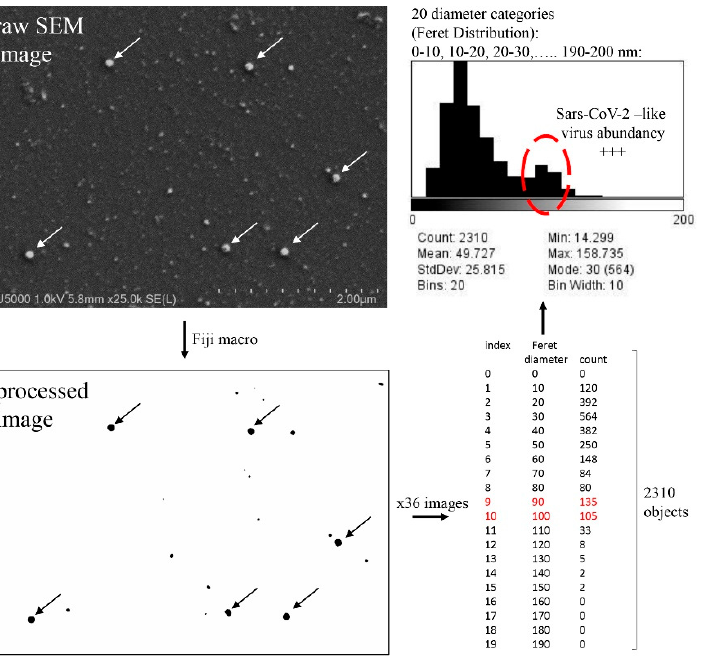
Figure 6. Example of Fiji macro for depicting 5 nm to 200 nm diameter particles in SEM images of SARS-CoV-2-infected cell culture supernatants. In this example SARS-CoV-2-infected cell culture supernatant with Ct value of 13.72 was concentrated by centrifugation on a 25XConA slide in a shell vial. Arrows point to Sars-CoV-2 virus-like particles in raw SEM and processed images. +++: peak.